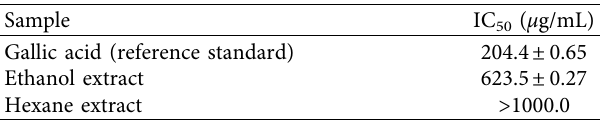
Table 4: IC 50 of hydrogen peroxide radical scavenging activity of extracts of O. basilicum .